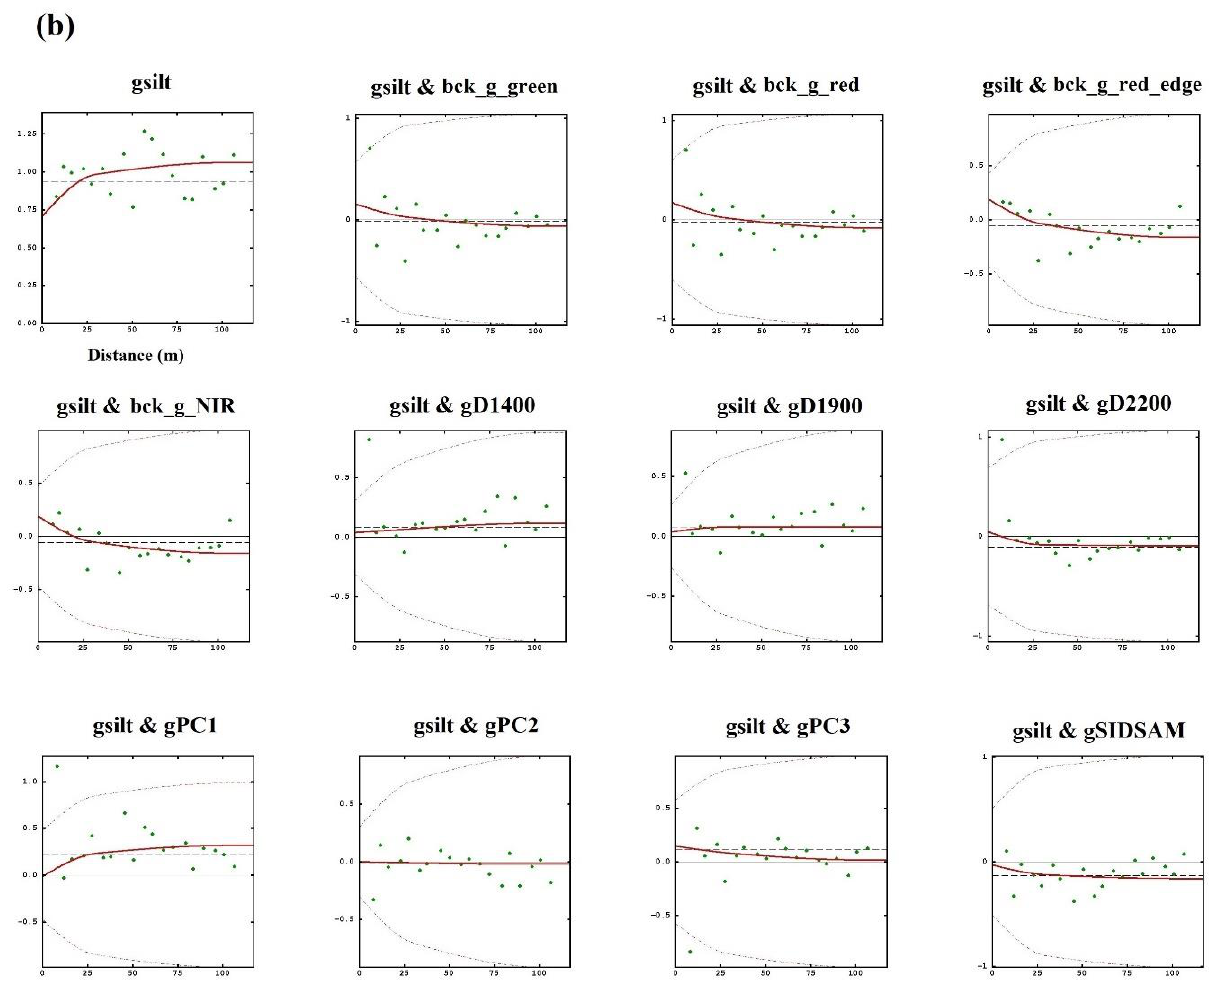
Figure 7. The direct and cross variograms of the two variables: gclay ( a ) and gsilt ( b ).